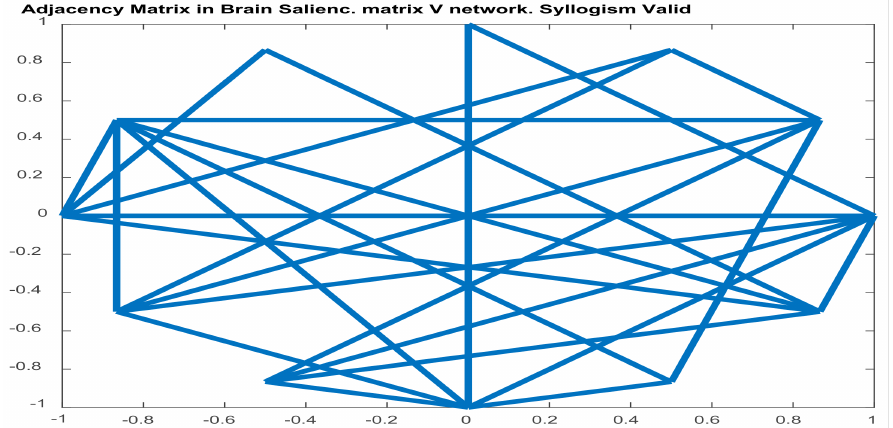
Figure 25. Adjacency matrix of the network generated by the brain salience matrix V, for the valid syllogism. The rows and columns of V are the nodes of the network, while the links correspond to elements of the weight matrix W (normalized V and taking its elements with a threshold = 0.20, i.e., retaining only the 20% of the strongest links). The density of the network is